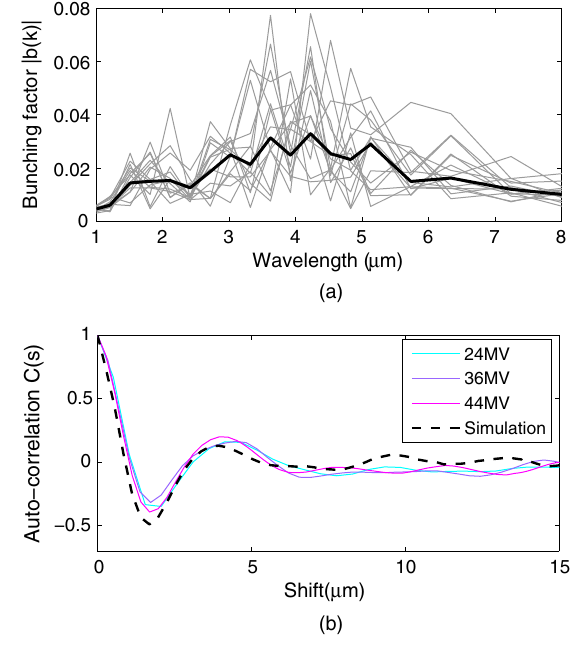
FIG. 8. (a) Single-shot (grey) and average (black) bunching factor with 0.5 kA and induced energy spread of 10 keV from the laser heater. Shot-to-shot fluctuations are consistent with a shot- noise seed. (b) Measured autocorrelation [Eq. (4)] compared to shot-noise simulation. The coherence length is independent of XTCAV voltage, showing the correlation is not resolution